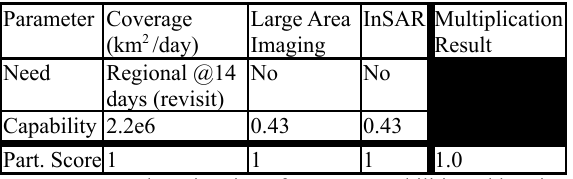
Table 5. Example estimation of percent capabilities addressing the desired needs for Commercial SAR assessment specific parameters (GO E9).